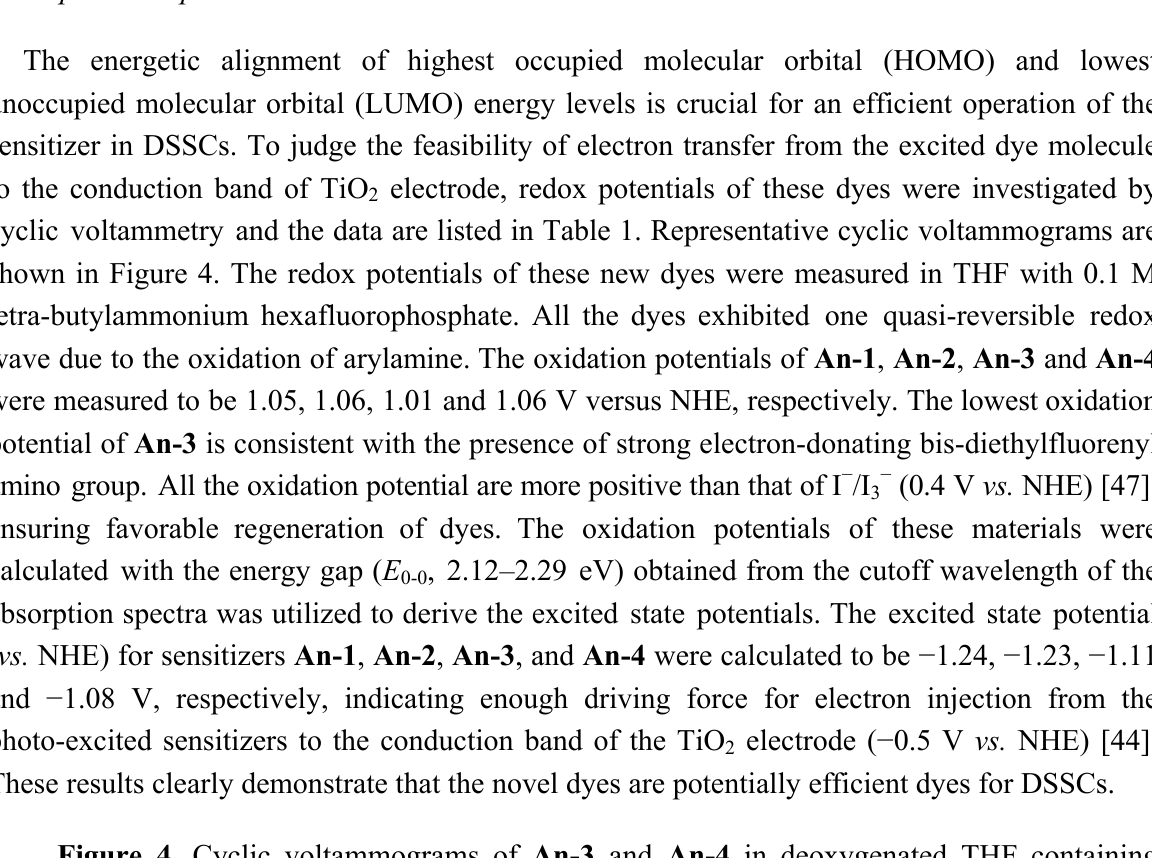
Figure 4. Cyclic voltammograms of An-3 and An-4 in deoxygenated THF containing at 25 °C. Ferrocene (Fc) was added as an internal standard. All potentials 0.1 M TBAPF 6 are in volts vs. Ag/AgNO (0.01 M in MeCN; the scan rate is 100 mV s − 1 3